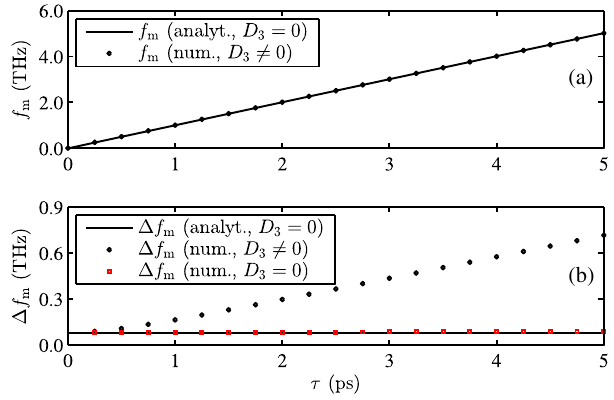
FIG. 3. Calculated modulation frequency f Δ f (b) as function of the interferometer delay τ (see text for m